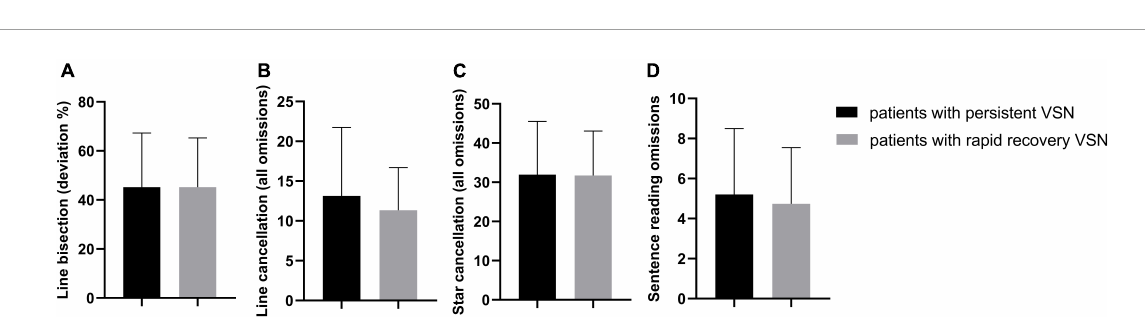
FIGURE2 The behavioral scores in two groups, all p > 0.05. (A) Line bisection (deviation %); (B) Line cancellation (all omissions); (C) Star cancellation (all omissions); (D) Sentence reading